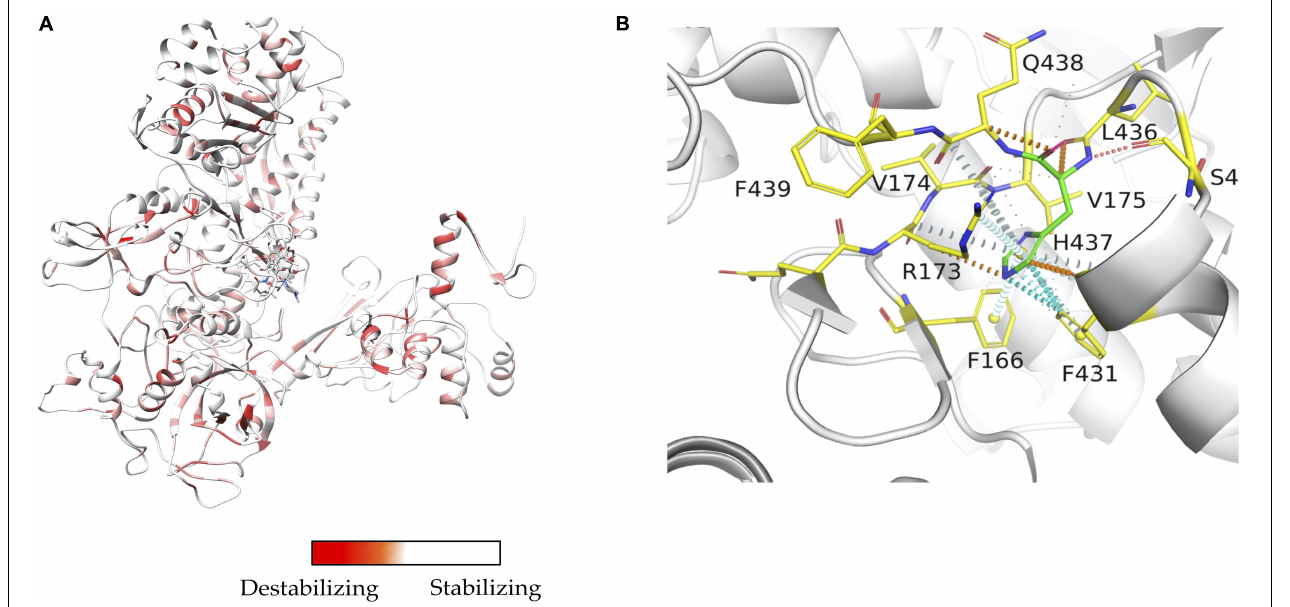
FIGURE 2 | (A) Stability changes predicted by mCSM for systematic mutations in the ß-subunit of RNA polymerase in M. leprae . The maximum destabilizing effect from among all 19 possible mutations at each residue position is considered as a weighting factor for the color map that gradients from red (high destabilizing effects) to white (neutral to stabilizing effects) (Vedithi et al., 2020). (B) One of the known mutations in the ß-subunit of RNA polymerase, the S437H substitution which resulted in a maximum destabilizing effect [-1.701 kcal/mol (mCSM)] among all 19 possibilities this position. In the mutant, histidine (residue in green) forms hydrogen bonds with S434 and Q438, aromatic interactions with F431, and other ring-ring and π interactions with the surrounding residues which can impact the shape of the rifampin binding pocket and rifampin affinity to the ß-subunit [-0.826 log(affinity fold change) (mCSM-lig)]. Orange dotted lines represent weak hydrogen bond interactions. Ring-ring and intergroup interactions are depicted in cyan. Aromatic interactions are represented in sky-blue and carbonyl interactions in pink dotted lines. Green dotted lines represent hydrophobic interactions (Vedithi et al.,